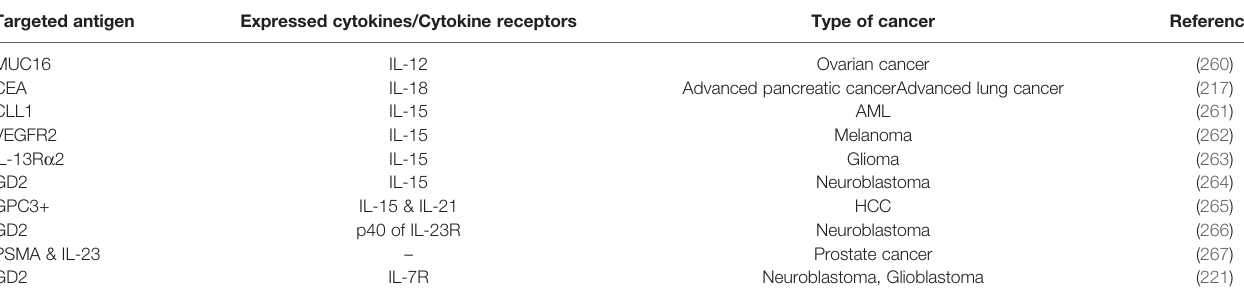
TABLE 8 | Summary of preclinical studies on CAR-T cells engineered to produce vital cytokines or to express transgenic cytokine receptors. Targeted antigen Expressed cytokines/Cytokine